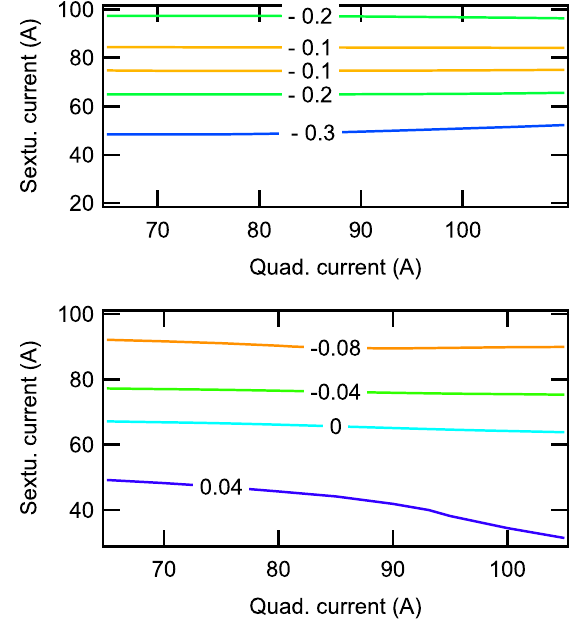
FIG. 9. 2D maps of the integrated gradient errors Δ G=G (in % of the QF4 integrated gradient). The contour plot on the top shows the contribution from the SF2 sextupole and the plot on the bottom shows the contribution from the QF4 quadrupole, at 75 cm pole-to-pole distance. The integrated gradient error is dominated by the response of the sextupole yoke to a quadrupole fringe field; the contribution of the quadrupole yoke is almost negligible. All these values were obtained from 3D simulations.